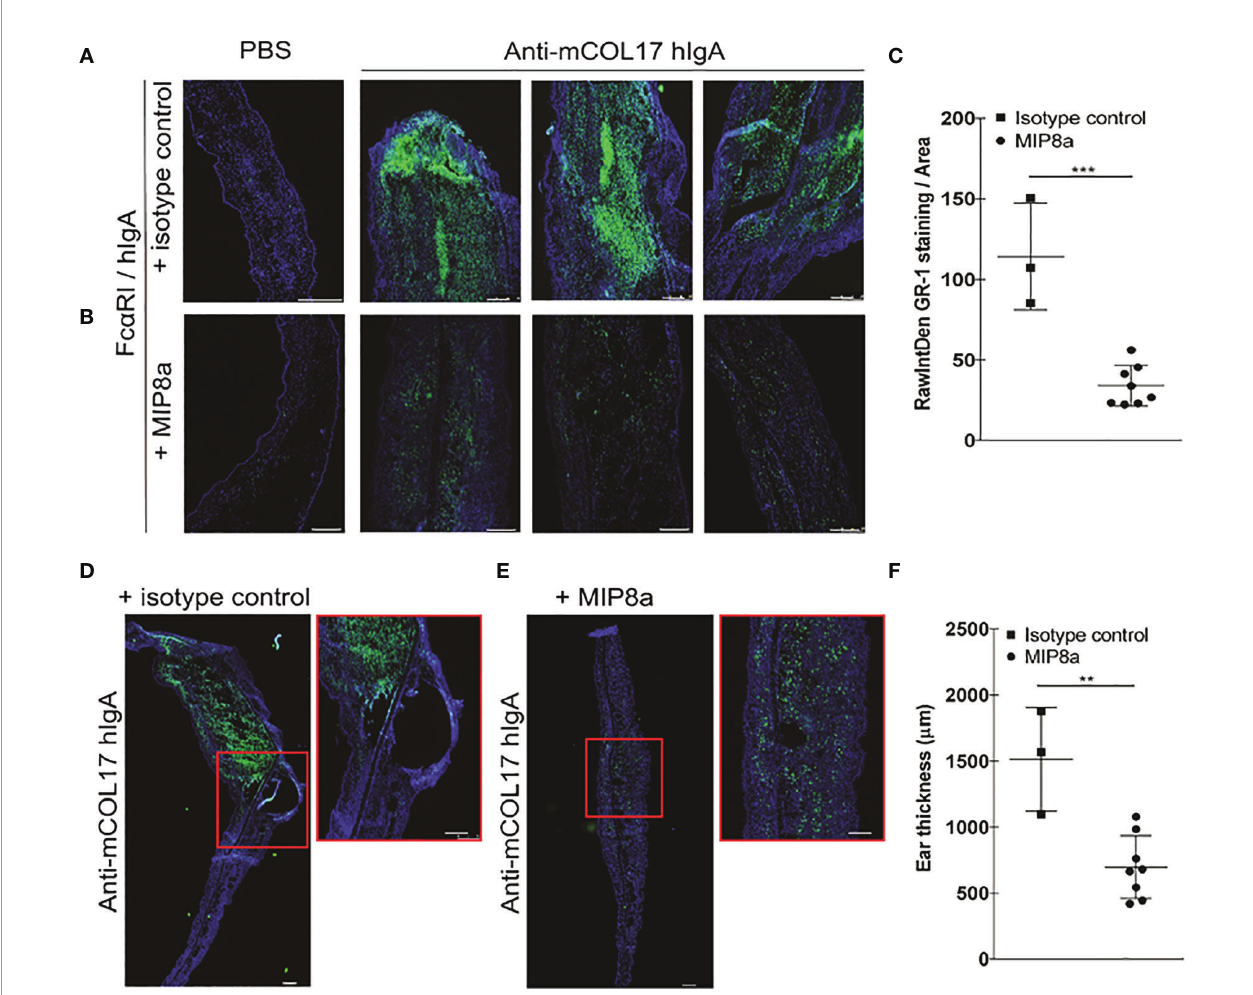
FIGURE 5 | Anti-Fc a RI mAbs signi fi cantly reduces lgA-induced neutrophil recruitment, existing chronic in fl ammation and tissue damage. Fc a RI/hlgA mice were injected with PBS (left ear) or anti-mCOL17 hlgA (right ear) every other day till sacri fi ce on day 14 (in total 7 injections). Mice were treated with an isotype antibody or anti-Fc a RI mAb MIP8a at day 8 and 11. (A, B) Fc a RI/hlgA mice were treated with an isotype control (A) or with MIP8a (B) . Left panels; PBS injection. Three representative examples of ears that had been injected with anti-mCOL17 hlgA are shown. (C) Quati fi cation of GR-1 staining. (D-F) Analysis of ear thickness. A representative example of mouse ear cryosection is shown after treatment with an isotype control (D) or MIP8a (E) . Inserts are magni fi cations. (F) Quanti fi cation of ear thickness. Each dot represents one mouse. Isotype control n = 3; MIP8a n = 8. Cryosections of ears stained for the neutrophil marker GR-1 (green) and DAPI (DNA; blue). Scale bars: 250 m m. Data are presented as mean ± SD. Student ’ s t test; **p < 0.05, ***p <